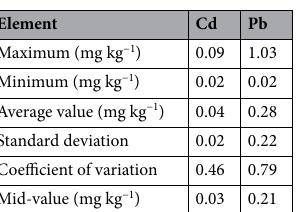
Figure 7. Pb concentrations at different depth in soil profiles. ( a ) D3 soil profile ( b ) D2 soil profile ( c ) D1 soil profile ( d ) D0 soil profile.